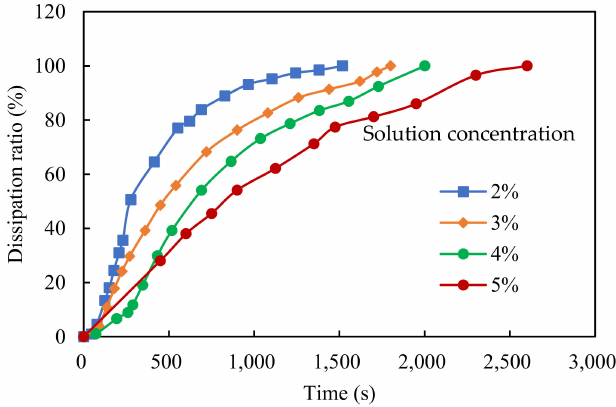
Figure 13. Dissipation curves of foam with different